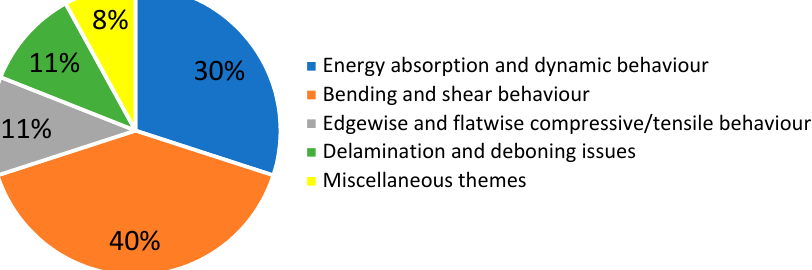
Figure 23. Percentages of different research themes regarding the structural performance of foam ‐ filled composite panels from 1998 to 2017.